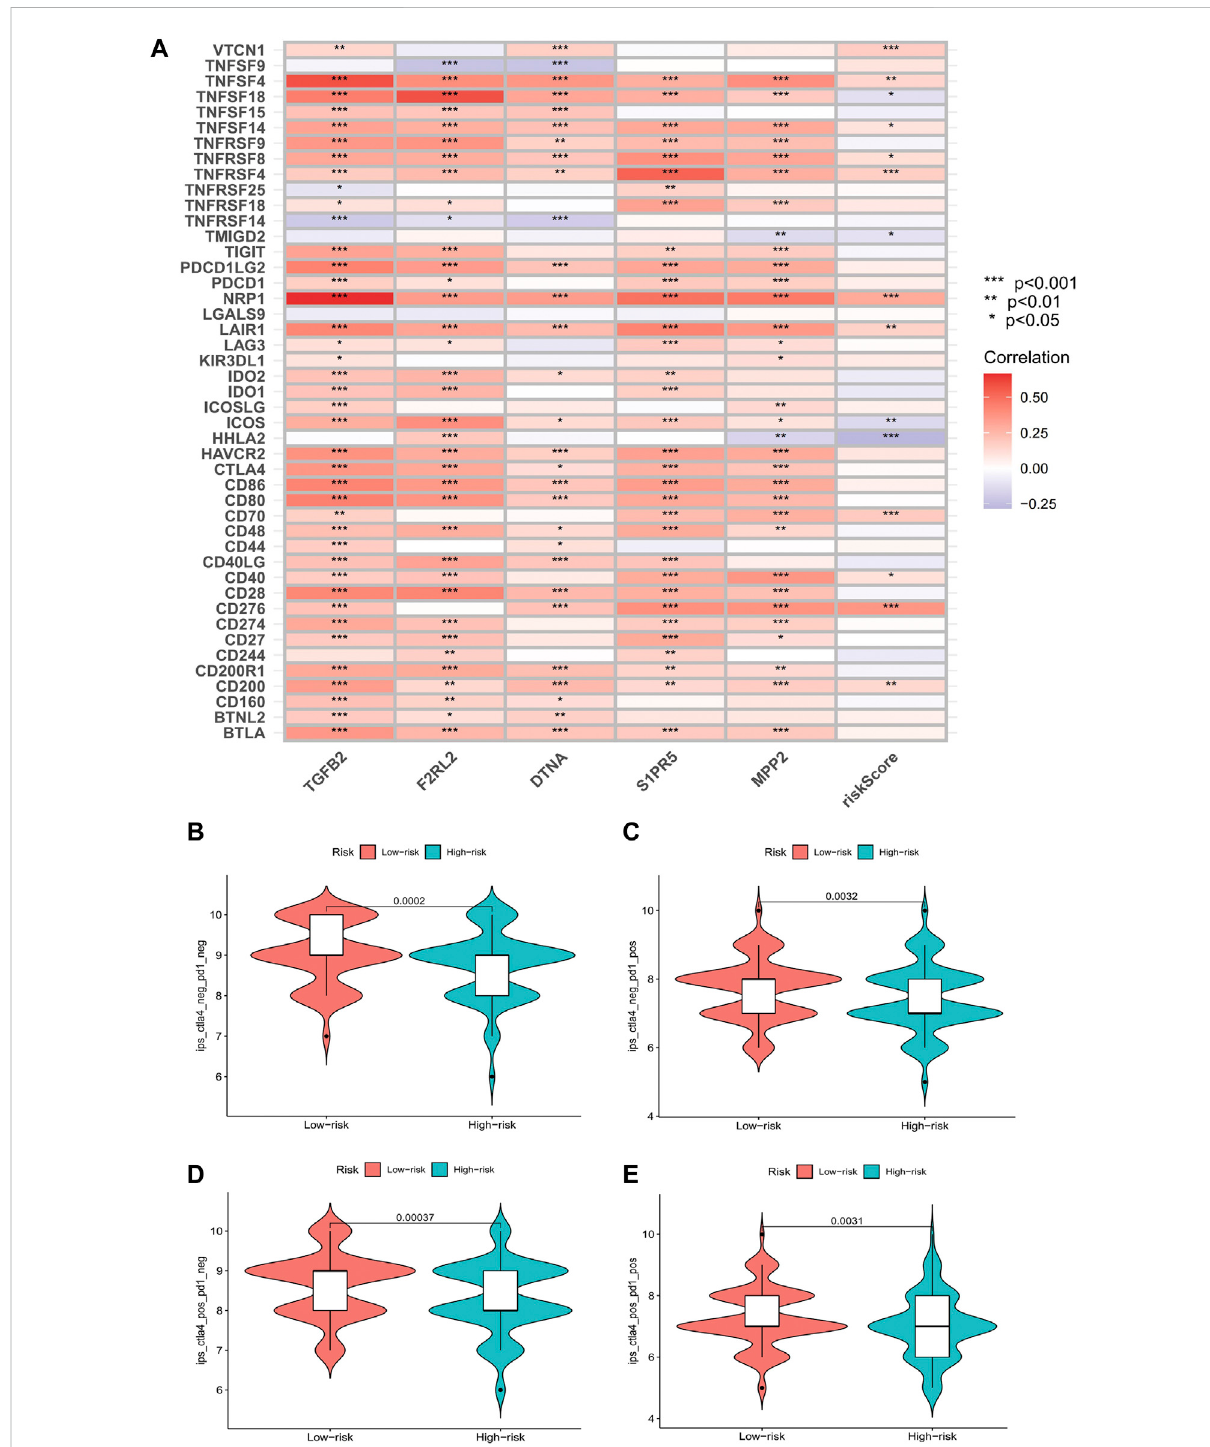
FIGURE 8 Resultsofimmunecheckpointsandimmunotherapyef fi cacyanalysis. (A) Heatmapsofimmunecheckpointsassociatedwithhubgenesandrisk score(* p < 0.05,** p < 0.01,and*** p < 0.001). (B – E) Violinplotoftheassociationbetweenimmunotherapyeffectandriskscore:controlgroup;anti- PD-1 group; anti-CTLA4 group; anti-PD-1/anti-CTLA4